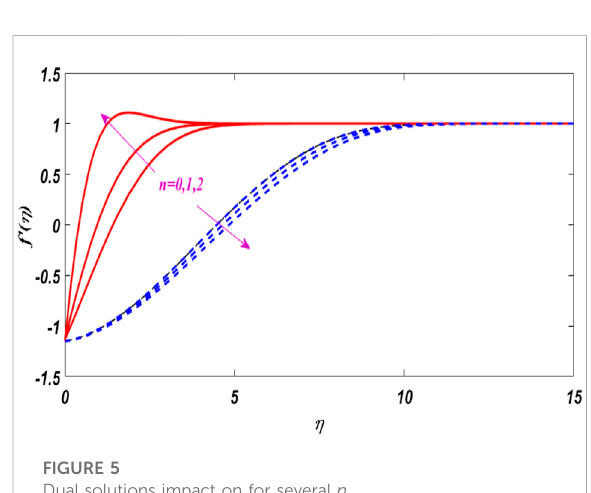
FIGURE 4 Dual solutions impact on f ′ ( η ) for several.